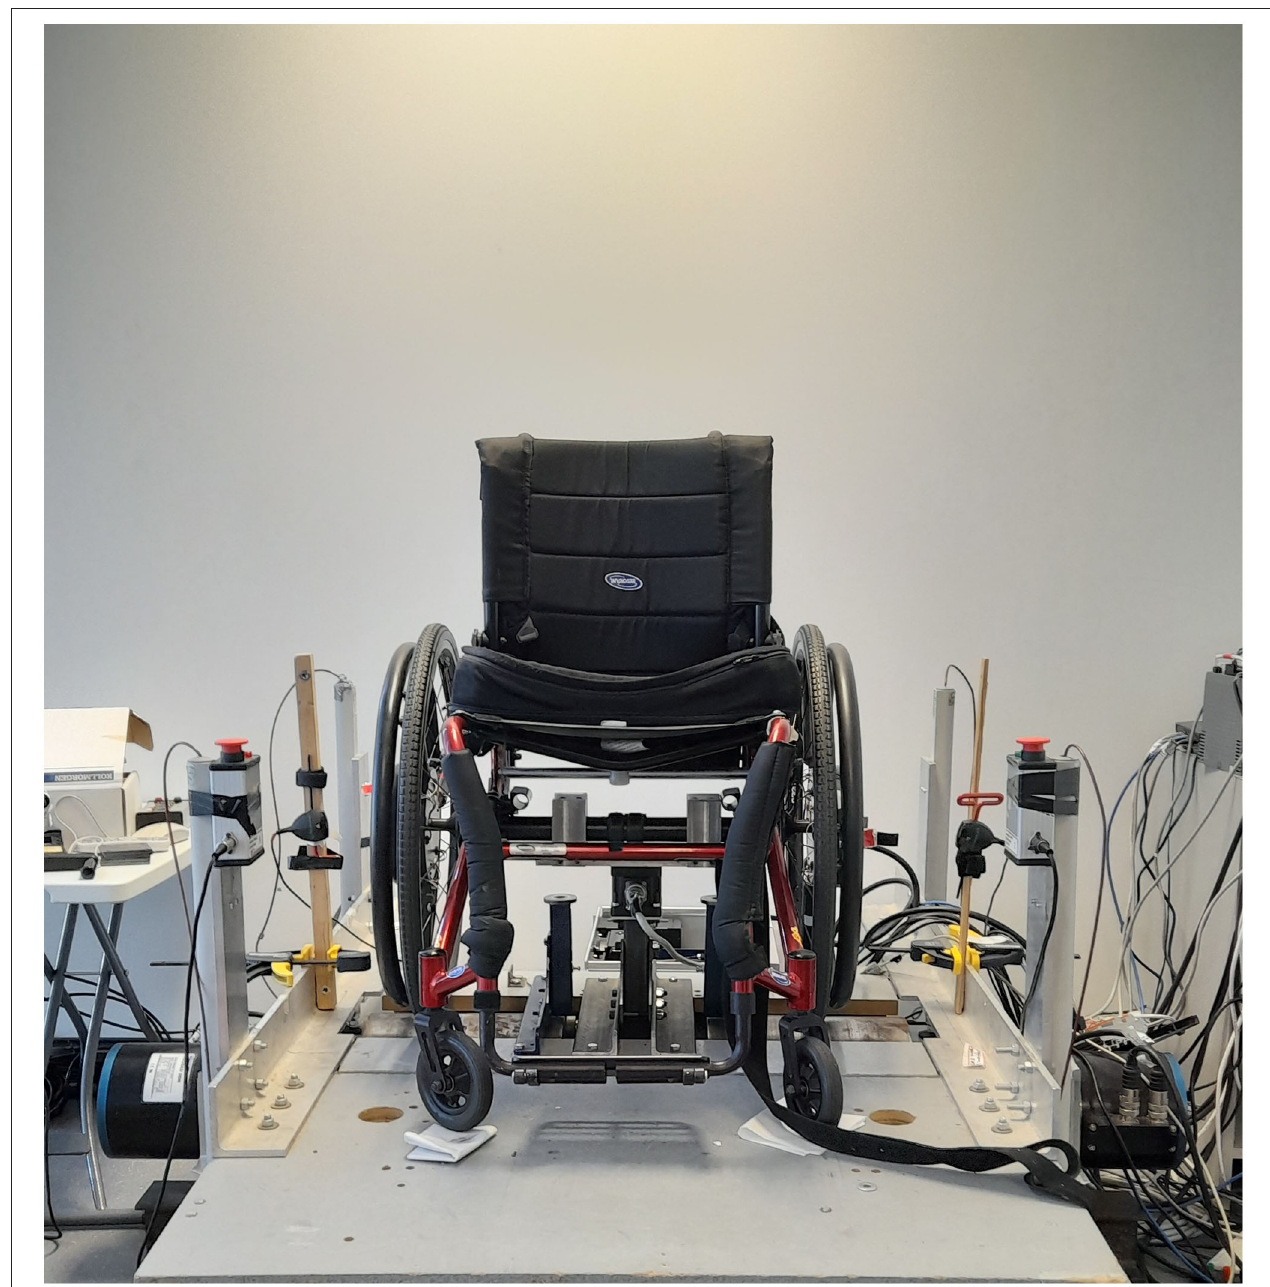
FIGURE 1 | Haptic wheelchair